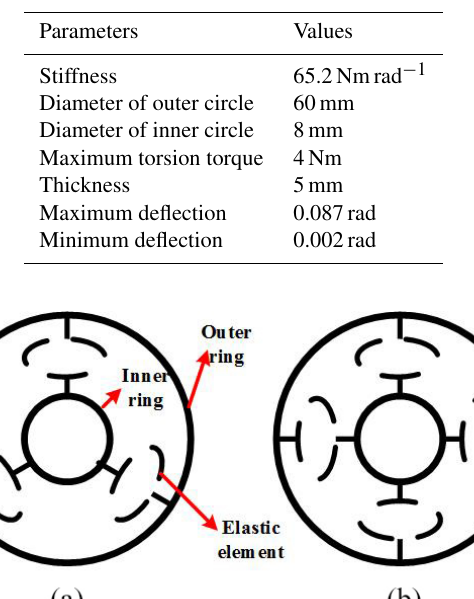
Table 1. Design requirements for the elastic module.